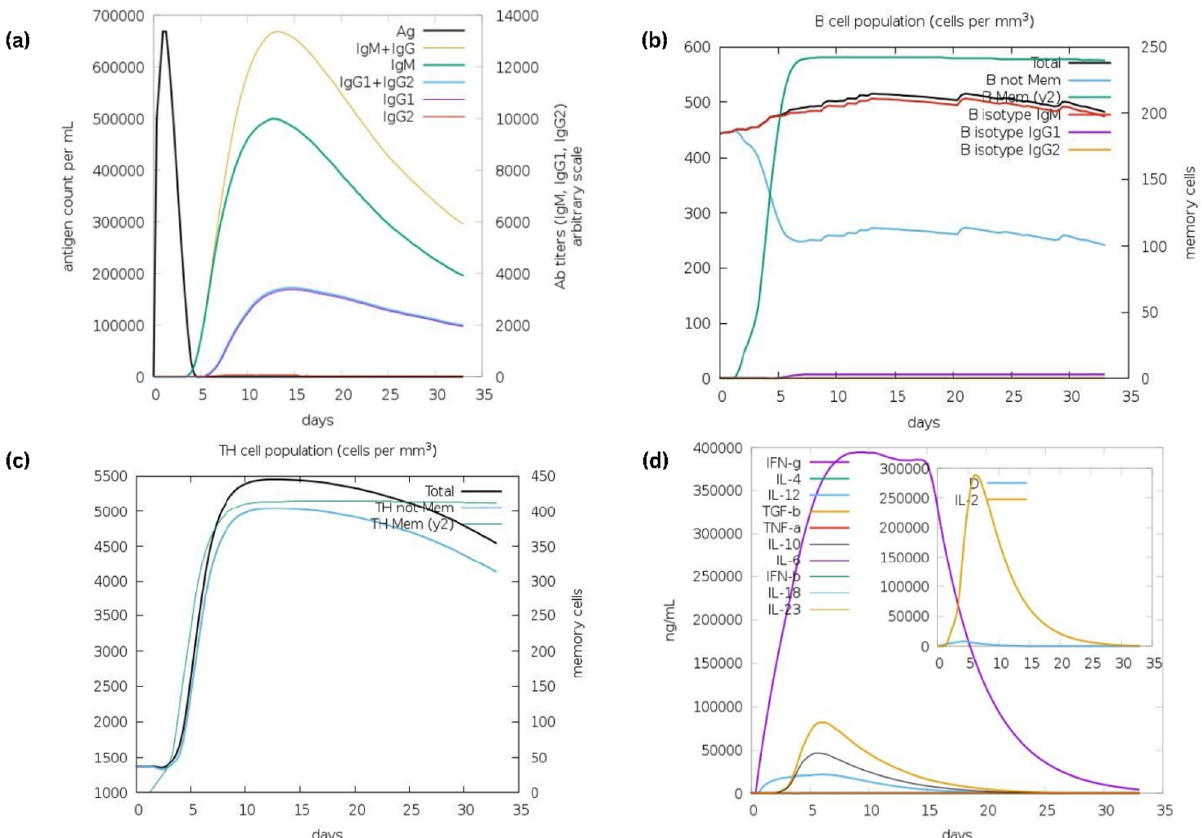
Figure 13. Immune simulation of multi-epitope vaccine: ( a ) immunoglobulin production on subse- quent injection of antigens (shown by black lines); colored lines indicative of immune cells class; ( b ) shows changes in B-cell population and memory formation; ( c ) production of helper T-cells; ( d ) elevated rates of cytokines and interleukins for effective immune response.